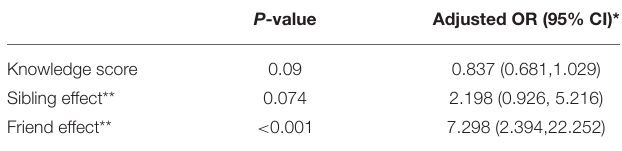
TABLE 5 | Determinants of e-cigarette